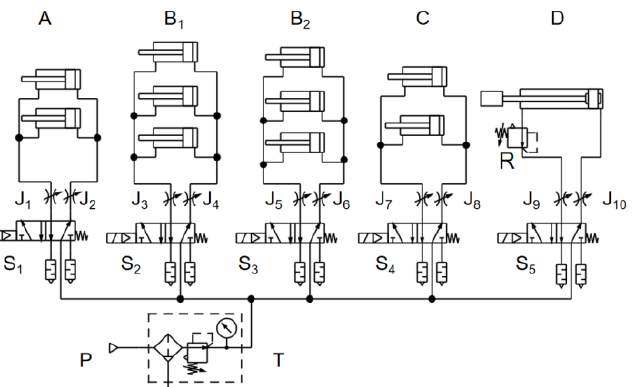
Figure 5. Pneumatic system diagram of seedling-picking mechanism: A is the lifting cylinder; B 1 and B 2 are the clamping cylinders; C is the horizontal cylinder; D is the longitudinal cylinder; J 1 – J 10 are the throttle valves; S 1 – S 5 are the solenoid valves; R is the safety valve; P is the air source; T is the air source regulating device.